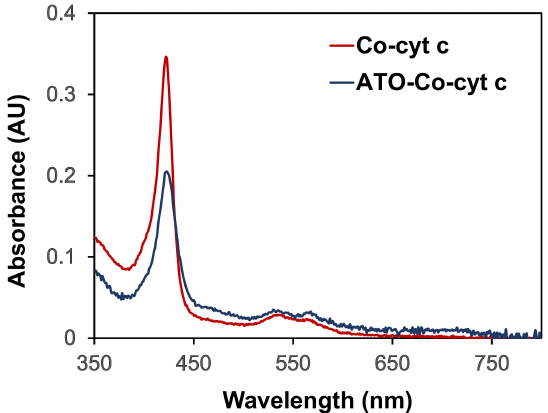
Figure 2. UV-Vis absorption spectra of Co-cyt c (3.2 µ M) in 100 mM tris, pH 7.5 (red), and Co-cyt c absorbed on ATO coated slide in air (blue). The absorption spectrum of ATO Co-cyt c was multiplied by 3 to improve the visuality. The Soret band maxima at 421 nm for both Co-cyt c in solution and on ATO represents the six-coordinated Co (III)-porphyrin.